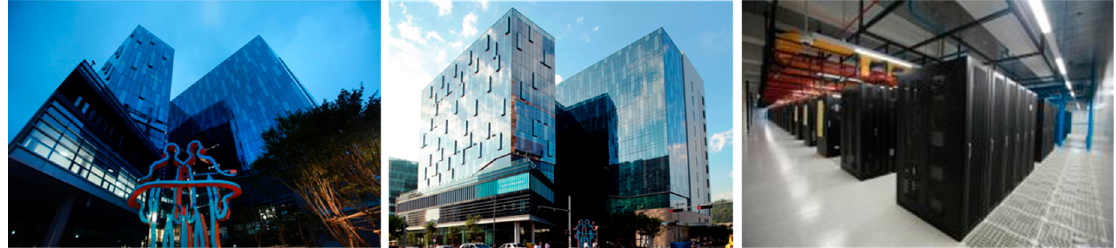
Figure 5. Relative failure rate versus temperature for volume servers [21].